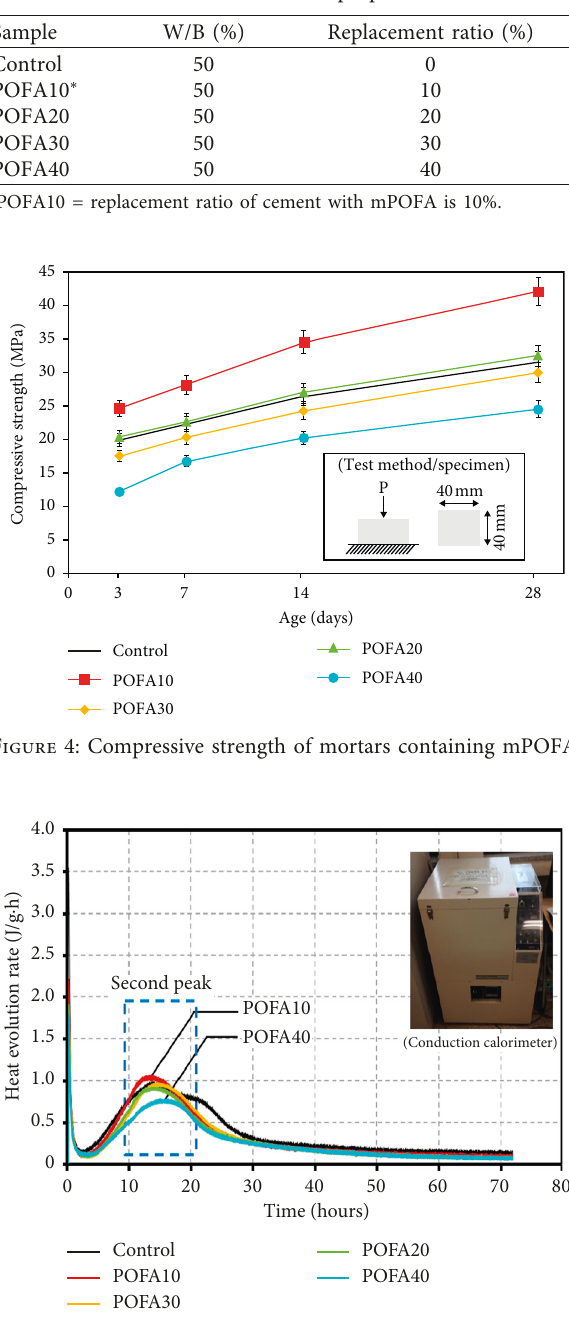
Figure 5: Heat evolution rate of mortars containing